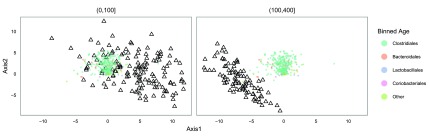
PLS produces a biplot representation designed to separate samples by a response variable.